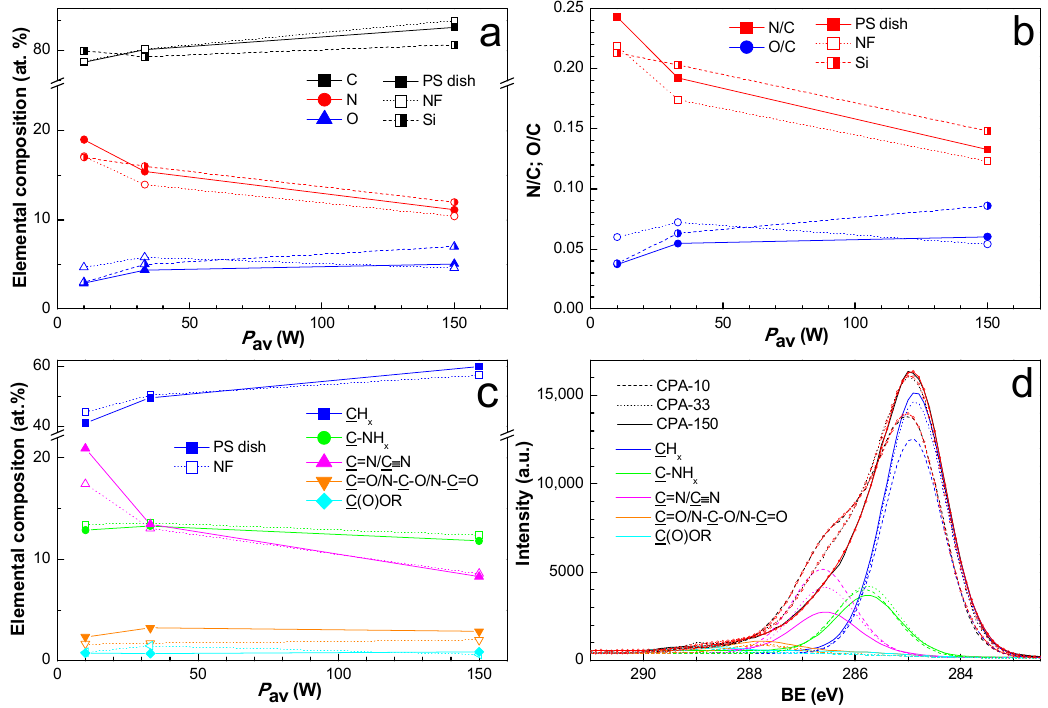
Figure 2. XPS chemical composition of PP-coated PS dishes and PP-coated polycaprolactone nanofibers (PCL NFs) aged two weeks supplemented with the chemical composition of PP-coated Si from our previous publication [37]: ( a ) elemental composition, ( b ) N / C and O / C ratios, ( c ) concentration of identified functional groups from C1s fitting, and ( d ) high-resolution C1s spectra with identified functional groups for PP-coated PCL NFs. PS dishes are denoted by full marks, PCL NFs are denoted by empty marks, and Si is denoted by half-full marks. CPA-10, CPA-33, CPA-150: PPs were deposited at the average RF power ( P av ) of 10, 33, and 150 W,